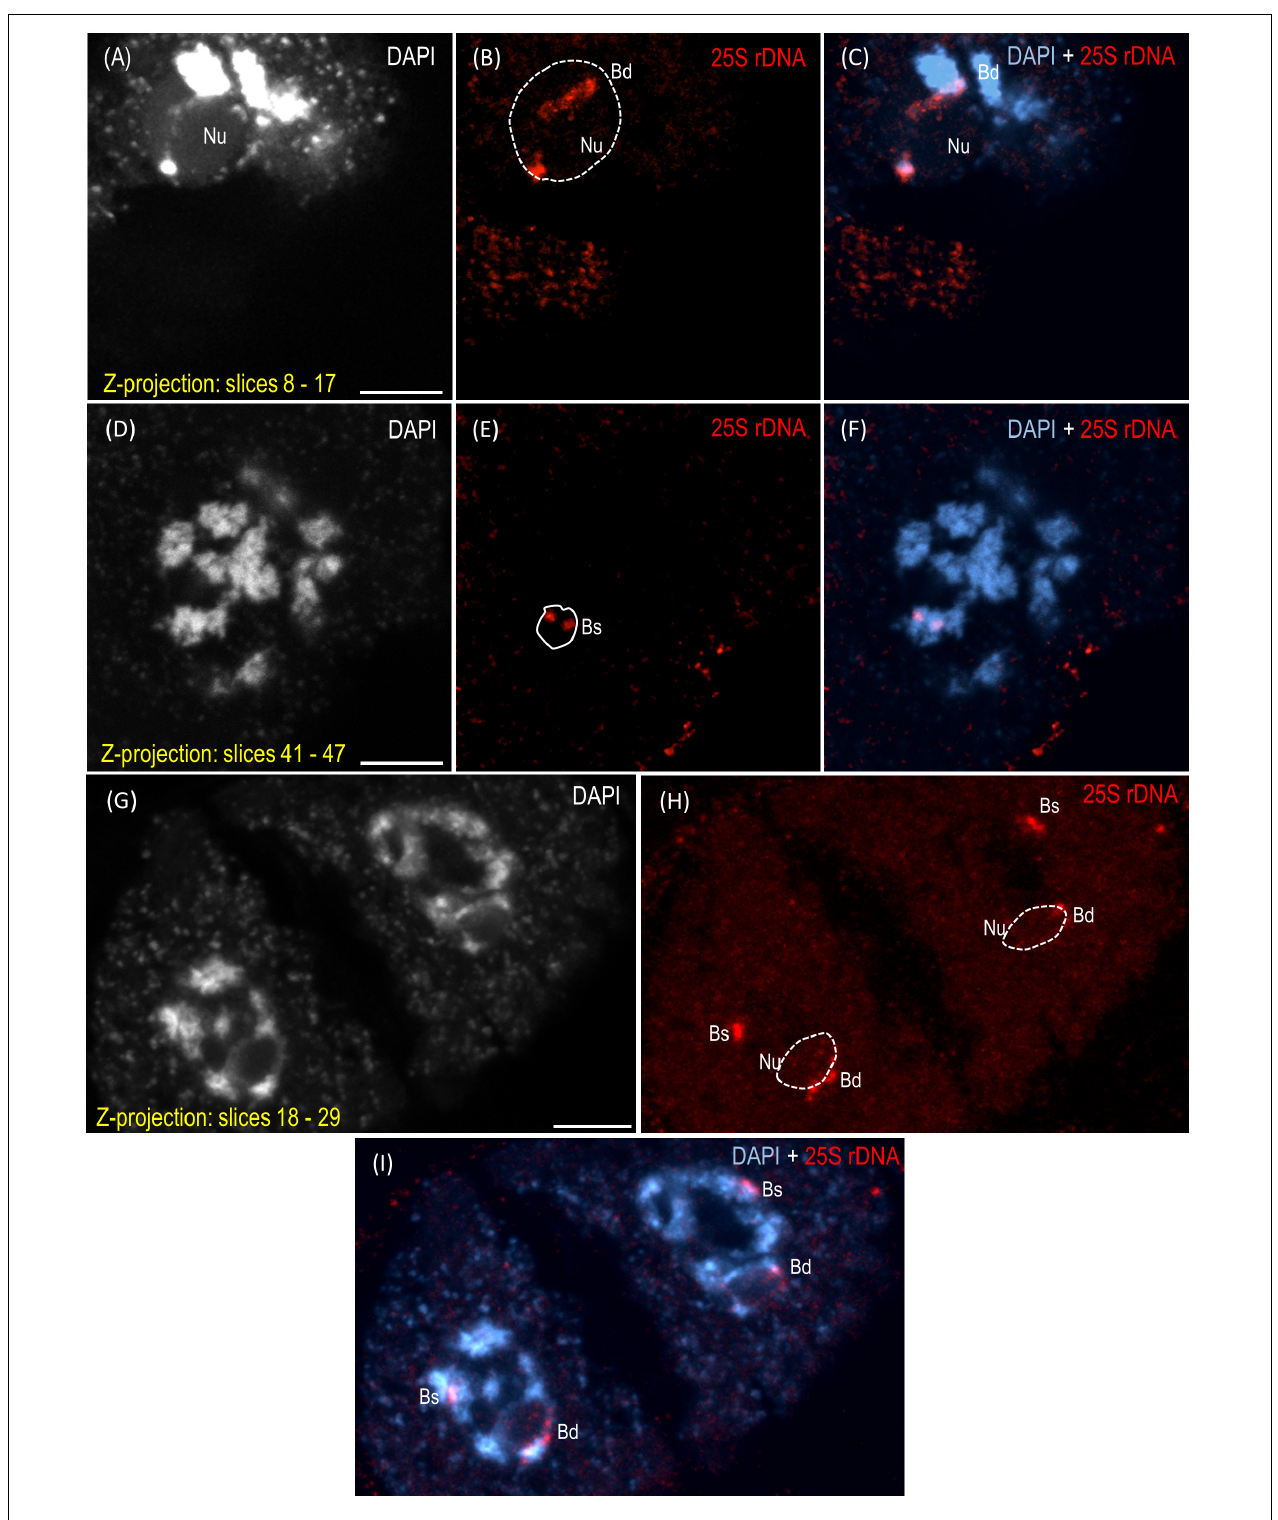
FIGURE 5 | Localization of the B. distachyon - and B. stacei -originated 35S rDNA loci in the 3-D cytogenetic preparations of B. hybridum meiocytes (genotype 3-7-2) at diakinesis and in dyads. Selected stacks that contain the 25S rDNA hybridization signals (red fluorescence) are presented. (A–F) Two different sections of one nucleus at diakinesis. (G–I) Dyad. Bd, B. distachyon -inherited 35S rDNA loci; Bs, B. stacei -inherited 35S rDNA loci; Nu, nucleolus. The position of the nucleolus in the 25S rDNA channel (B,E,H) is denoted by a dashed line. Chromatin was counterstained with DAPI. Scale bar = 5 µ